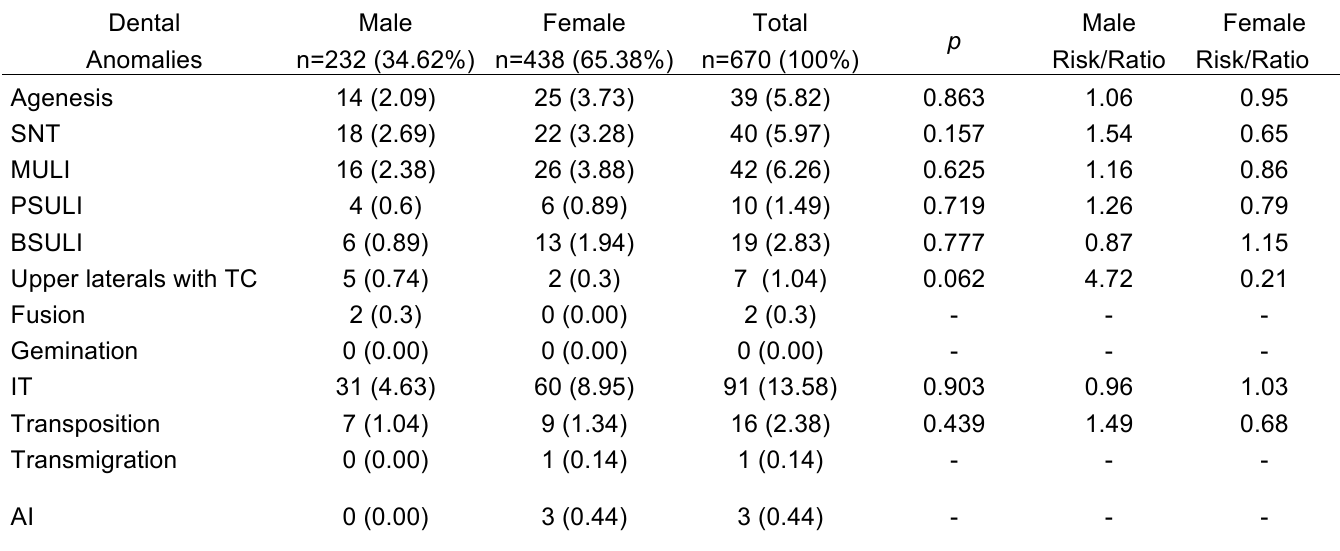
Table 1. Prevalence and distribution of dental anomalies by sex in a group of 670